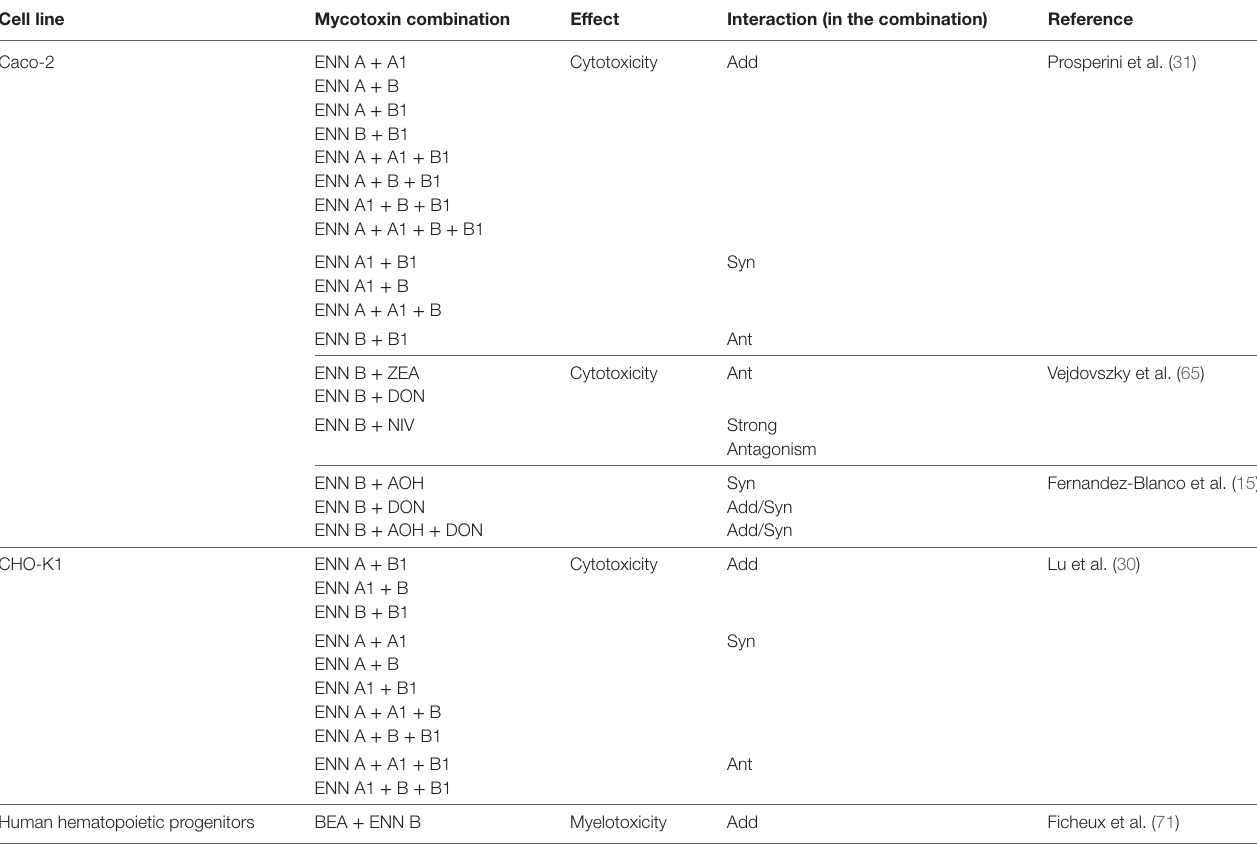
TABLe 3 | Combinedeffect of ENN B tested in combination with other mycotoxins by in vitro